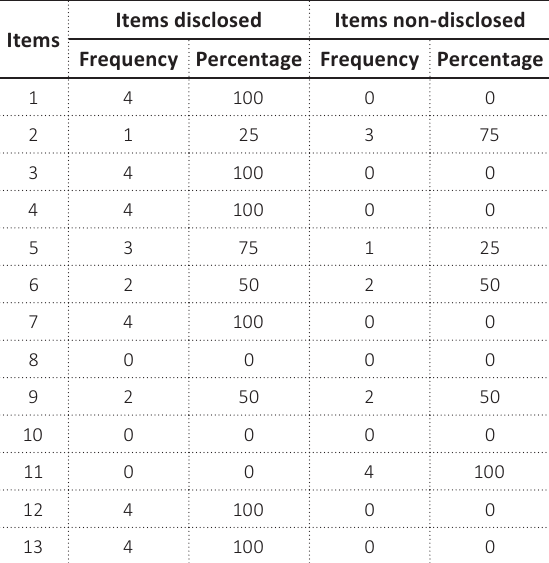
Table 2. Frequency analysis of EC